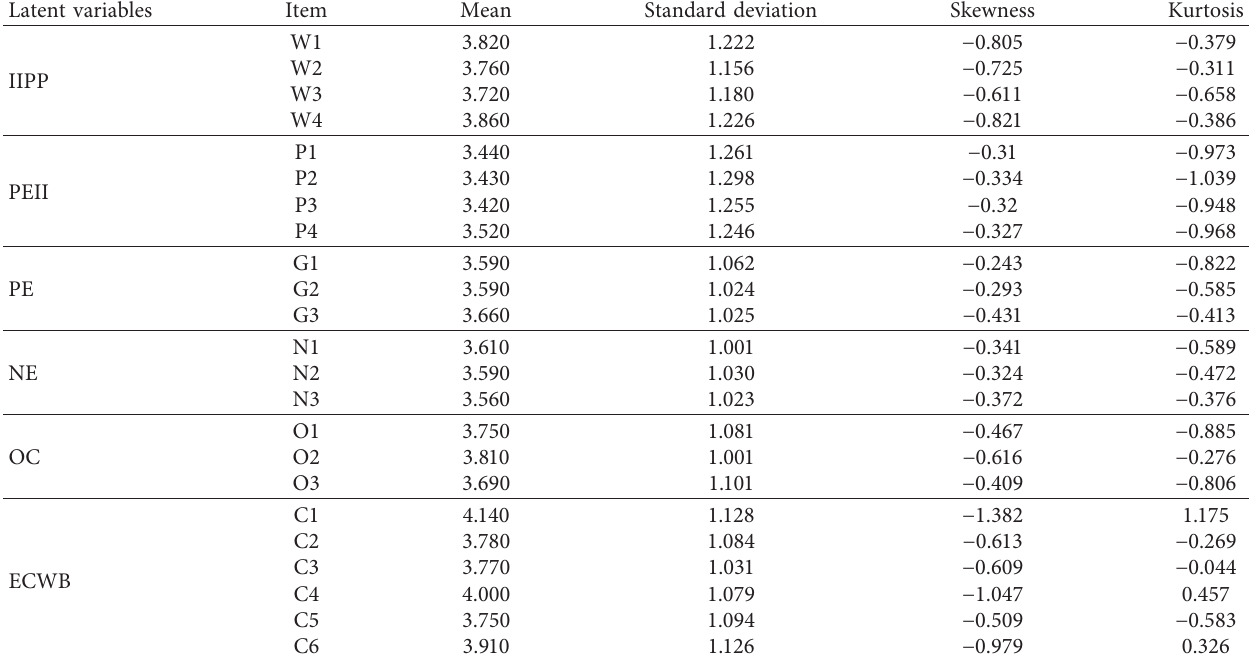
Table 1: Descriptive statistical analysis ( N � 336).